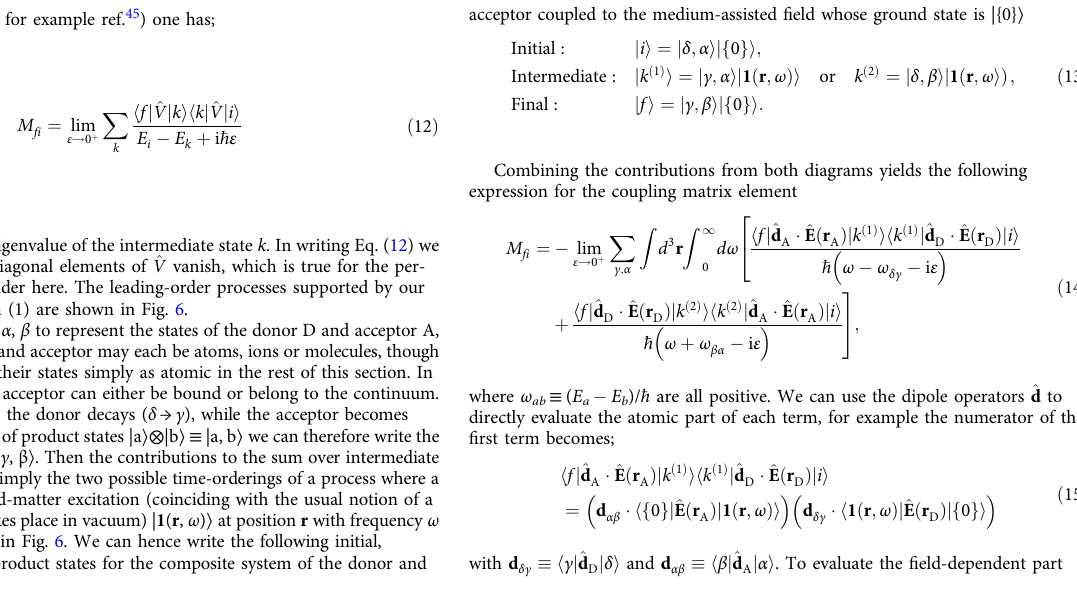
Fig. 4 Interatomic Coulombic decay rate near a dielectric surface. Non-retarded interatomic Coulombic decay rate Γ NR with Drude – Lorentz permittivity as given by Eq. (9), normalised to the free-space non-retarded rate Γ NR distance z D from the dielectric, which occupies the region z < 0. The acceptor is at position ( x A ,0, z A ), which is varied and the rate shown at each position in the x − z plane. All distances are normalised to z D , and the Drude – Lorentz parameters are ω p = ω S and γ = ω S /10. The white contours represent the position at which the free-space and surface-modi fi ed rates are equal. In the insets we plot the behaviour of the re fl ection coef fi cient R as a function of frequency near its resonance ω S , and show with a vertical line the ICD frequency ω D chosen in the corresponding plot. The off-resonance plots ( a , b and d ) share the same scale, while the on-resonance plot ( c ) has a much larger range due to the strong enhancement of the rate if the ICD and material resonance frequencies are